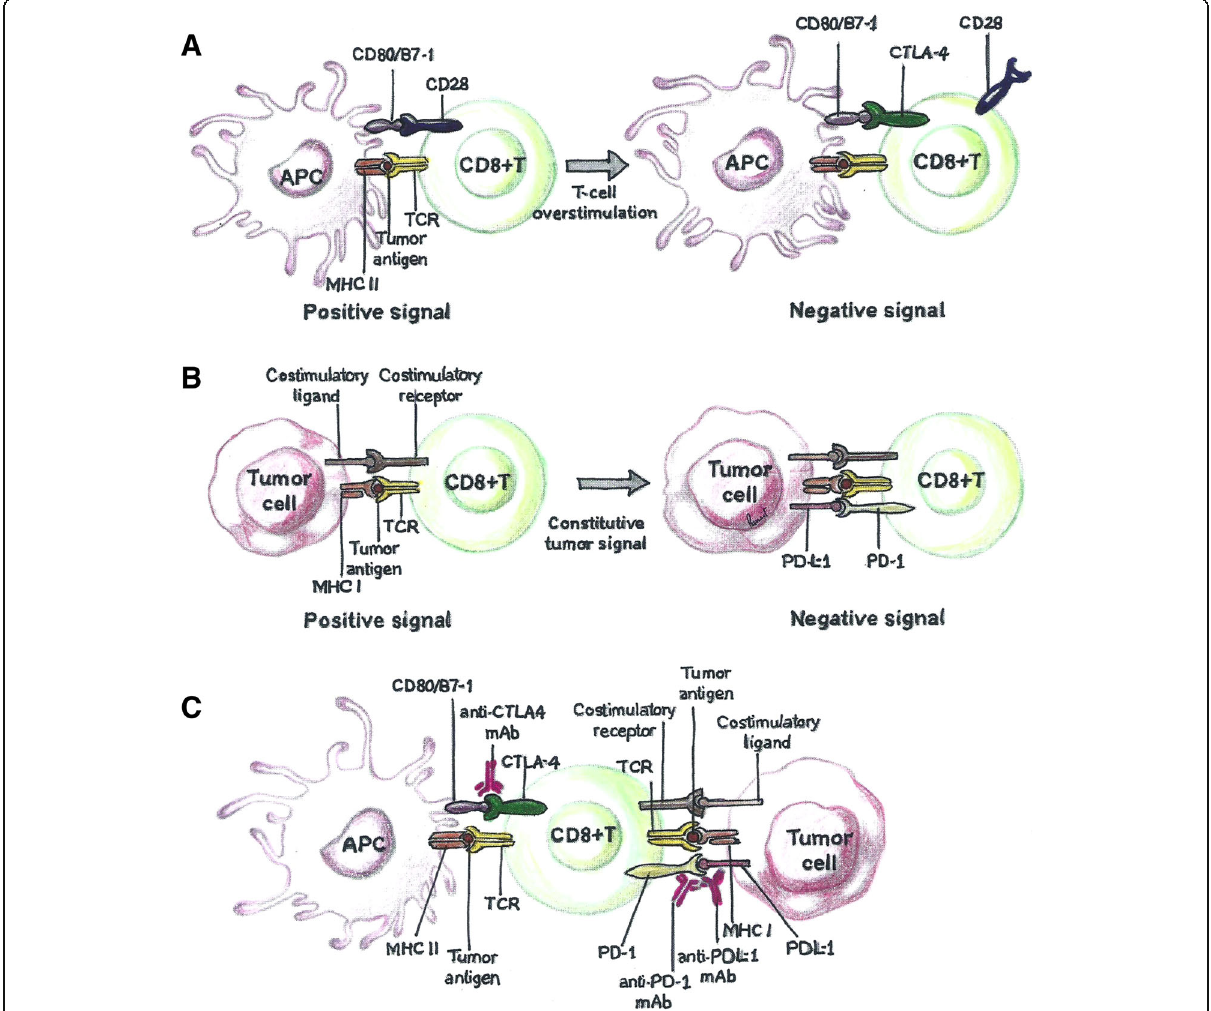
Fig. 2 Immune checkpoint inhibition pathways in tumors ( a ) Activation of CTLA-4 pathway: Naive and memory T cells express high levels of cell surface CD28 but do not express CTLA-4 on their surface. Instead, CTLA-4 is sequestered in intracellular vesicles. CTLA-4 is a CD28 homologue with higher affinity for the ligands CD80 (B7 – 1) or CD86 (B7 – 2) that it shares with CD28. After the T-cell receptor (TCR) is triggered by an antigen encounter, CTLA-4 is transported to the cell surface. The stronger the stimulation through the TCR and CD28, the greater the amount of CTLA-4 that is expressed on the T-cell surface, resulting in a net negative signal transduced by the CTLA-4: CD80/86 interaction. This mechanism results in CD8 + T-cell inhibition, despite the presence of widely varying concentrations and affinities of ligand for the TCR. The negative T-cell inhibition or immunosuppressive signal is characterized by decrease in cytokine secretion, CD8 + T-cell inactivation and loss of its cytotoxic function ( b ) Activation of PD-1/PD L-1 pathway: PD-1, a member of the B7/CD28 family of co-stimulatory receptors, regulates T-cell activation through binding to its ligands, programmed death ligand 1 (PDL-1) and programmed death ligand 2 (PDL-2). During inflammatory responses in tissues or in the setting of chronic antigen exposure (including tumor antigens), activated T-cells up-regulate PD-1 and continue to express it in tissues. In case of tumors, constitutive tumor signal (tumor antigen and PDL-1 expression) results in overstimulation of CD8 + T cells and inhibits them by inducing a state of anergy or exhaustion. c During Immune Checkpoint Inhibition therapy, anti CTLA-4, anti-PD-L1 or anti-PD-1 antibodies bind to their corresponding target molecules preventing the receptor-ligand interactions of these immune checkpoint inhibitors. This releases CD8 + T-cells from immunosuppression imposed on them either by tumor cells via PD-1/PDL-1 pathway or by CTLA-4 pathway, which then resume